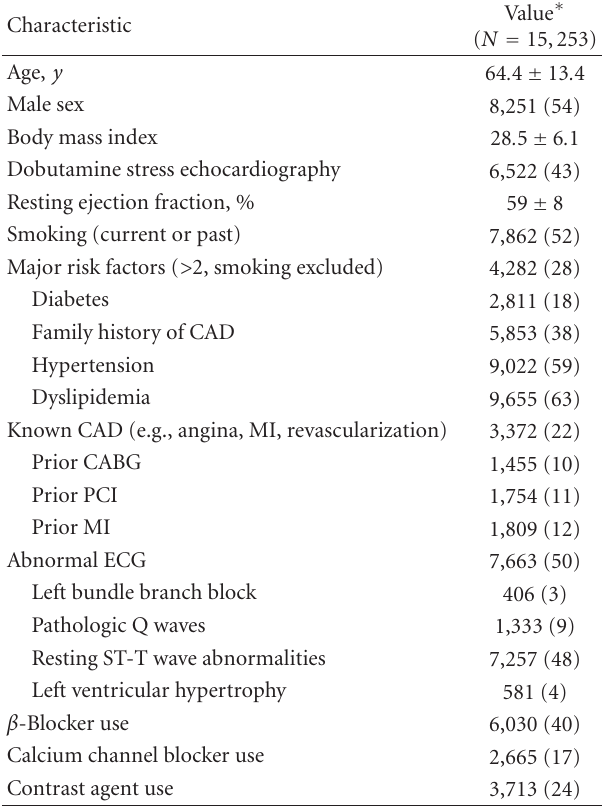
Table 1: Clinical characteristics of the studied population of